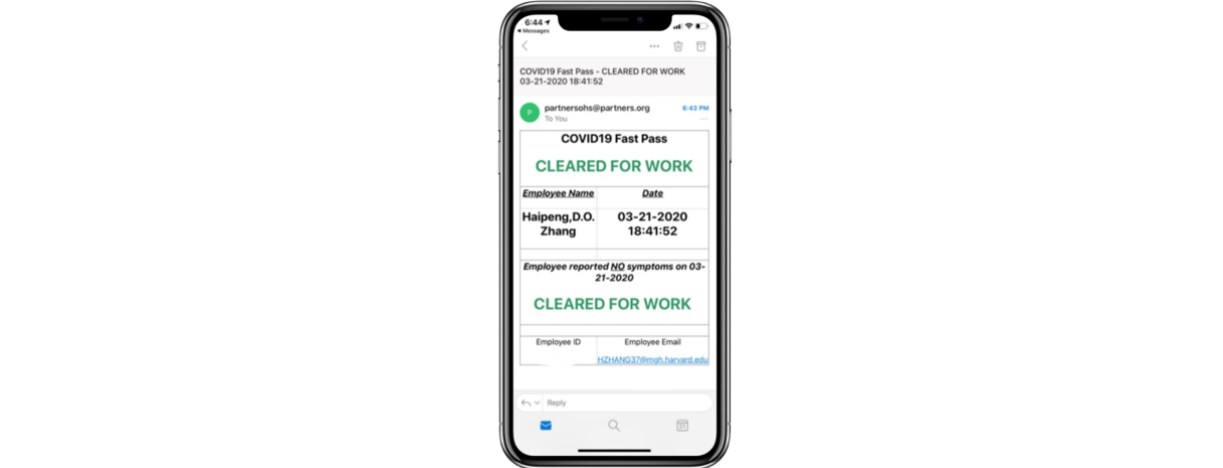
Figure 2. “Cleared for Work” screen of the COVID Pass